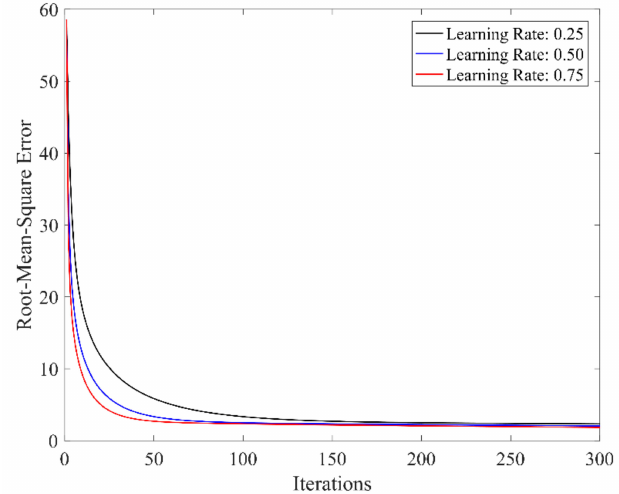
Figure 6. Relationship between error cost and learning times under di ff erent learning rates ( n =